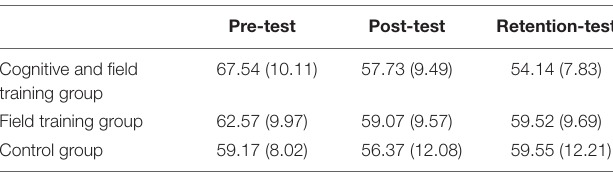
TABLE 1 | Comparison of performances in pre-, post-, and retention-tests differentiated by groups (means and SDs in pixels). Pre-test Post-test